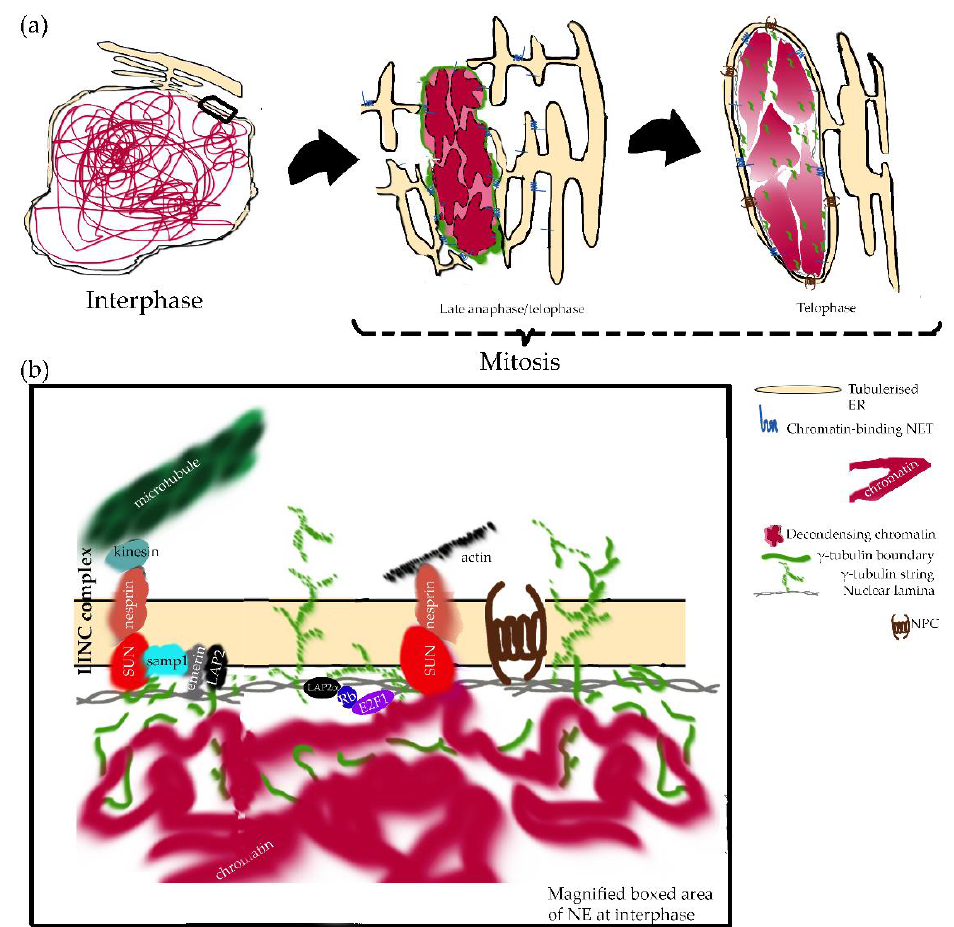
Figure 1. A model for the role of nuclear γ -tubulin in chromatin enclosing, inner nuclear membrane (INM) protein recruitment, and nuclear pore complex (NPC) formation in nuclear disassembly and reassembly upon cell division. ( a ) Schematic representation of the nucleus and nuclear envelope (NE) during interphase and subsequent mitosis. Post-mitotic reassembly of the NE is initiated by changes at the chromatin surface (i.e., removal of mitotic histone marks by phosphatases) and dephosphorylation-induced binding of nuclear envelope transmembrane proteins (NETs) and their associated membranes to chromatin. Engulfment of recently separated sister chromatids by the NE occurs via deposits of membrane fragments on the chromatin surface that trigger the enveloping process. The NE is reformed from endoplasmic reticulum (ER) membranes, which contact chromatin either as tubules or sheets. After membrane deposition, NPC assembly allows importation of the elements for nuclear lamina assembly. Microtubule organizer γ-tubulin plays a distinct role in promoting this NE formation by providing a γ-tubulin boundary indispensable for NE assembly. At the onset of mitosis, the lamina meshwork is disrupted, but the γ-tubulin boundary around the mitotic chromosomes is maintained. During mitosis, chromatin-associated γ-strings link the sister chromatids to the cytosolic γ-string pool. Finally, at anaphase/telophase, the γ-tubulin boundary composed of cytosolic and chromatin-associated γ -strings forms a supporting sca ff old that assists the formation of the nuclear envelope. ( b ) Magnified boxed area of NE at interphase: During interphase, γ -tubulin bridges connect the cytosolic and the nuclear γ -tubulin pools ([123], reviewed in [128,129]). The LINC protein nesprins recruit centrosomal proteins and regulate the nucleation of microtubules from the NE in myotubes [130]. The INM protein Samp1 is in contact with both γ -tubulin and SUN1 [131]. At the beginning of mitosis, during the rupture of the NE to the spindle microtubules, Samp1 might recruit γ -tubulin from the fenestrated NE. In the spindle, γ -tubulin and Samp1 complex together with augmins would potentially assist in the nucleation of the microtubules. Not to